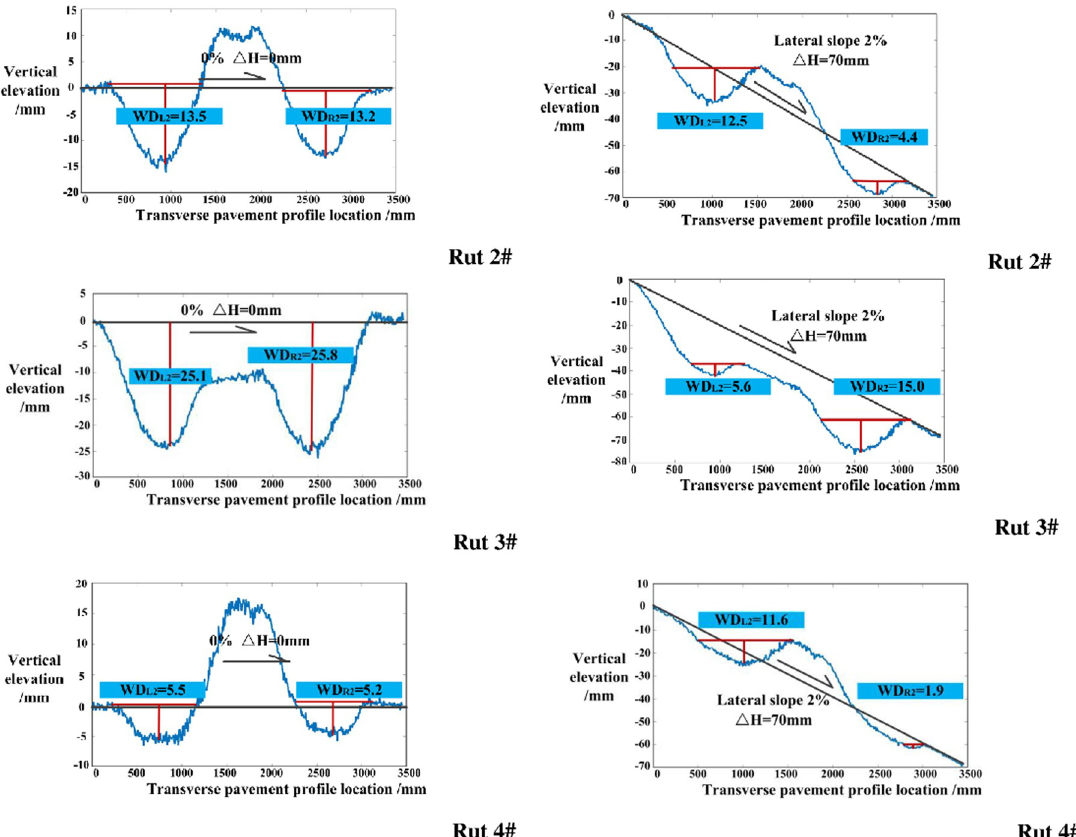
Fig 8. Change in the water-filled rut depth (taking 0% to 2% change of lateral slope as an example).